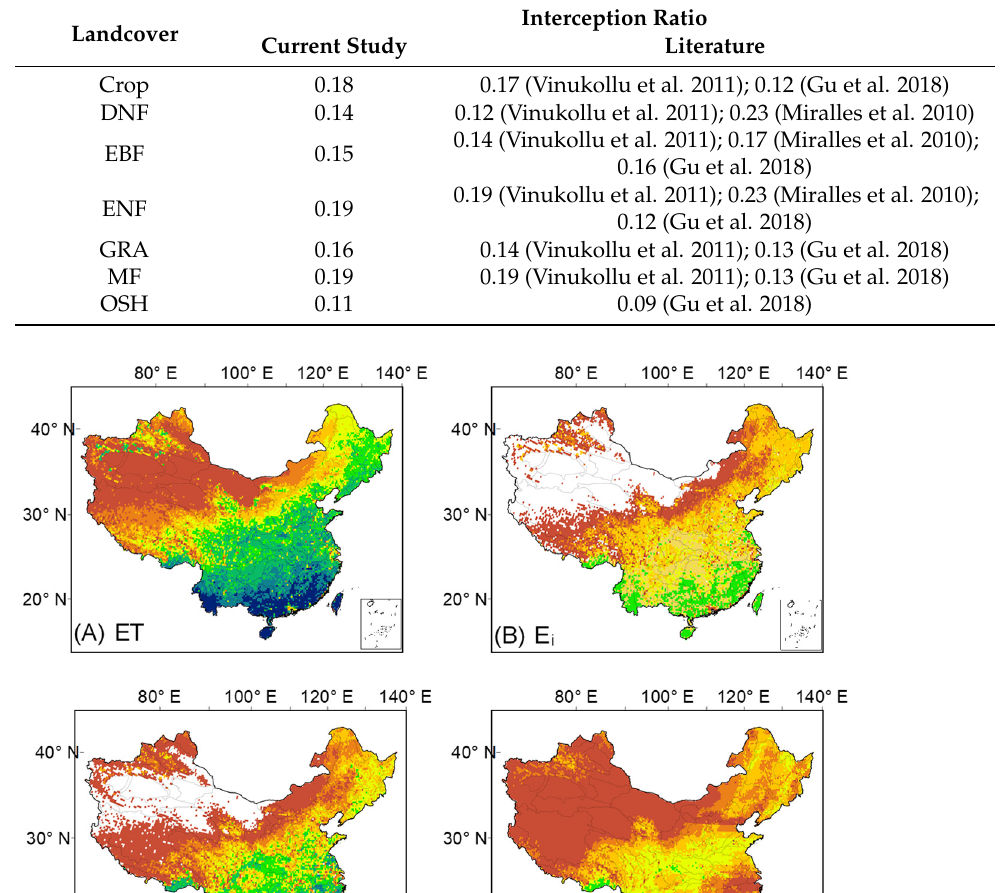
Table 4. Annual ratios (average) of canopy evaporation losses to the total precipitation based on land cover types.